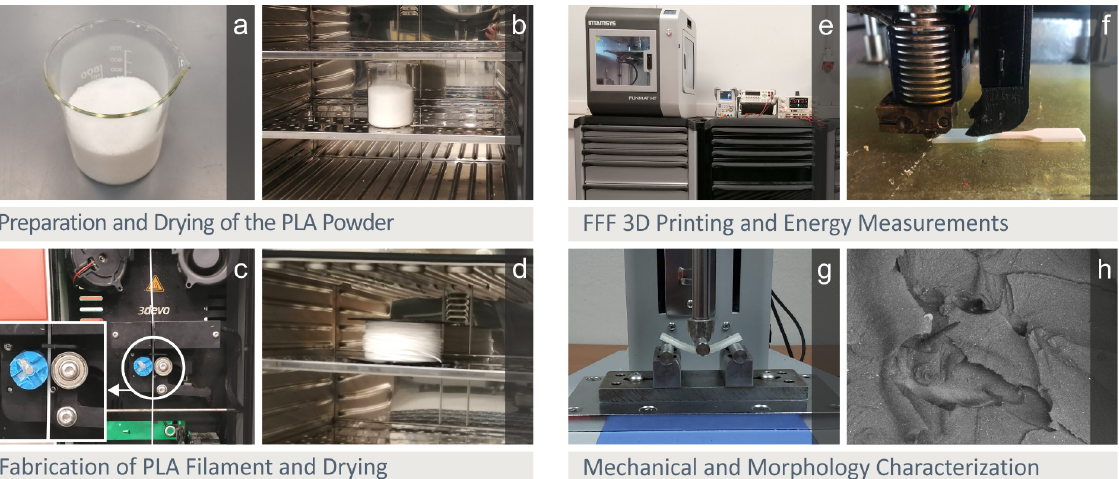
Figure 1. Experimental process ( a ) PLA raw material, ( b ) drying process for the raw material, ( c ) extrusion process for filament production, ( d ) drying of the filament, ( e ) measurements for the energy consumption during the FFF MEX 3D printing process, ( f ) FFF MEX 3D printing, ( g ) tensile experiments, ( h ) SEM images acquisition for the morphological characteristics’ evaluation.